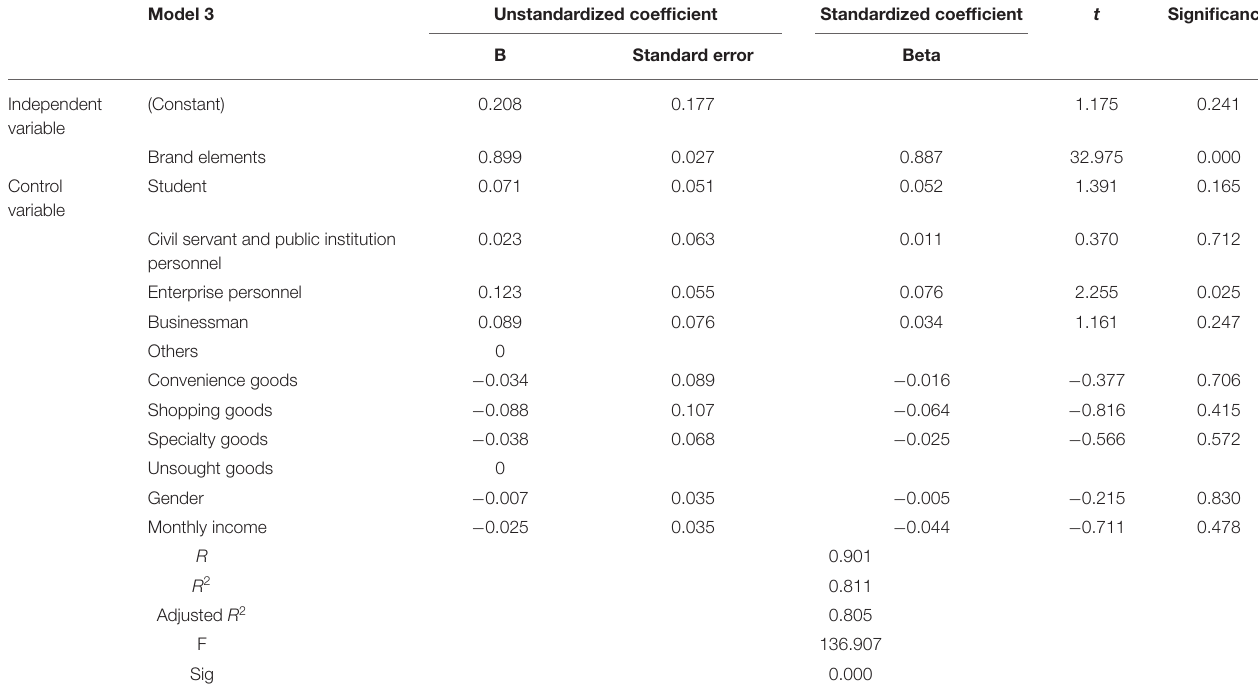
TABLE 4 | Regression analysis of brand elements to experience